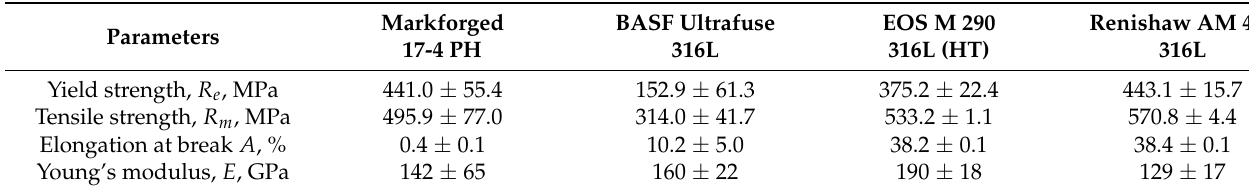
Table 5. Results of tensile tests (mean ± standard deviation).